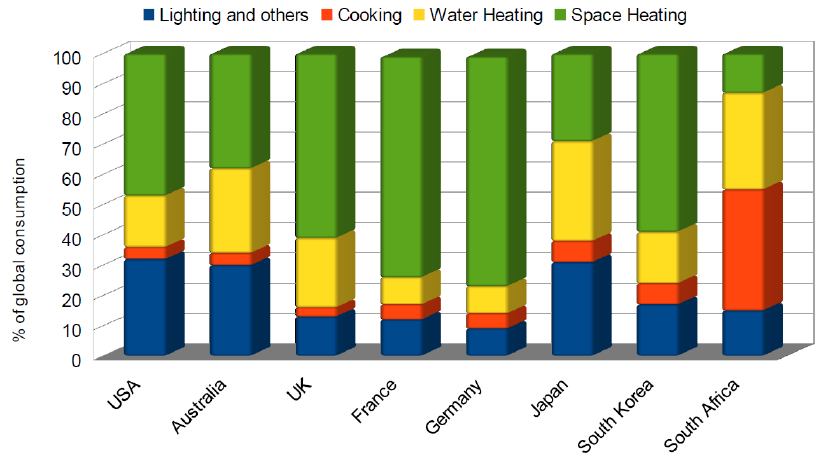
Figure 1. Energy used in residential environments in several countries